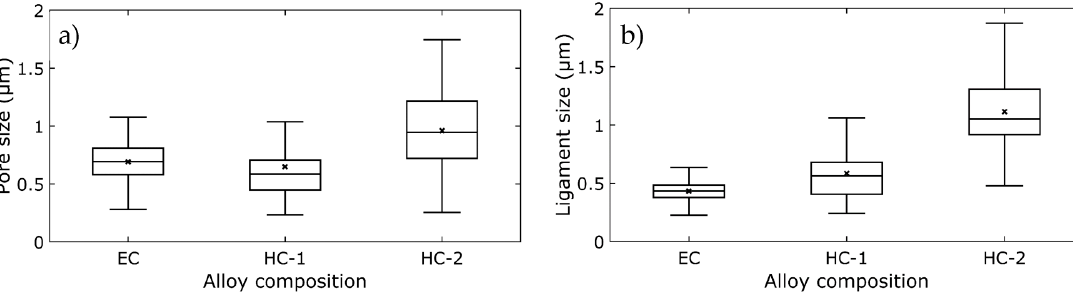
Figure 11. Box plot of: ( a ) pore size and ( b ) ligament size for the three compositions studied. Table 3. Pore and ligament size measurements.